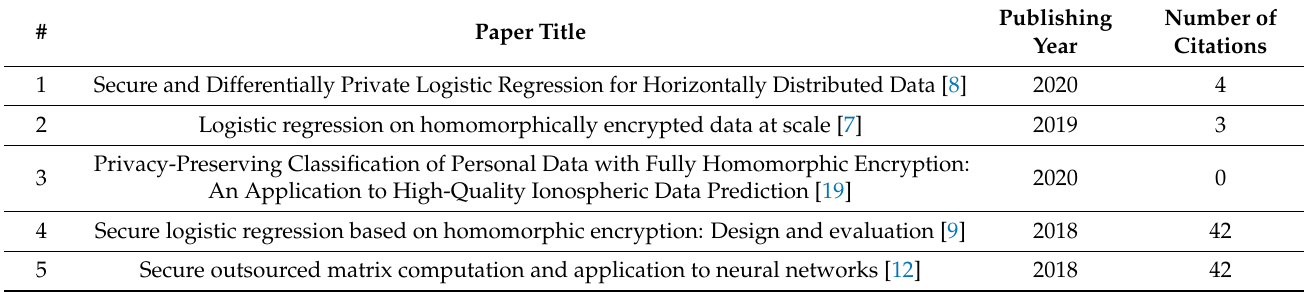
Table 10. Related literature on homomorphic encryption logistic regression.